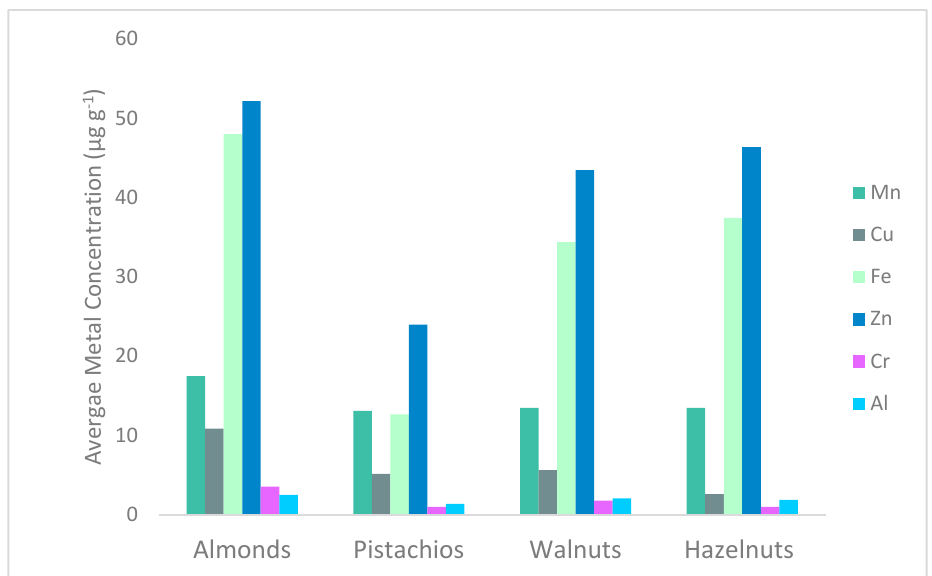
Figure 10. Average content of Mn, Cu, Fe, Zn, Cr and Al among almonds, pistachios, walnuts and hazelnuts available in a Greek market.